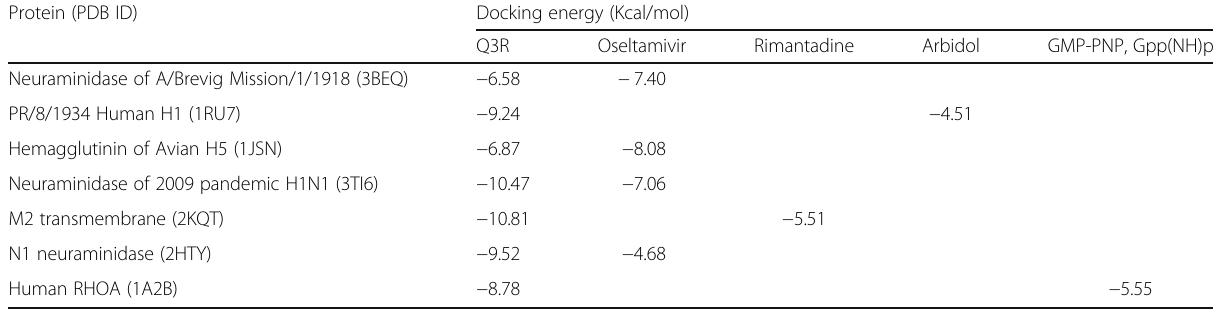
Table 3 The docking energy of Q3R with the studied receptors Protein (PDB ID) Docking energy